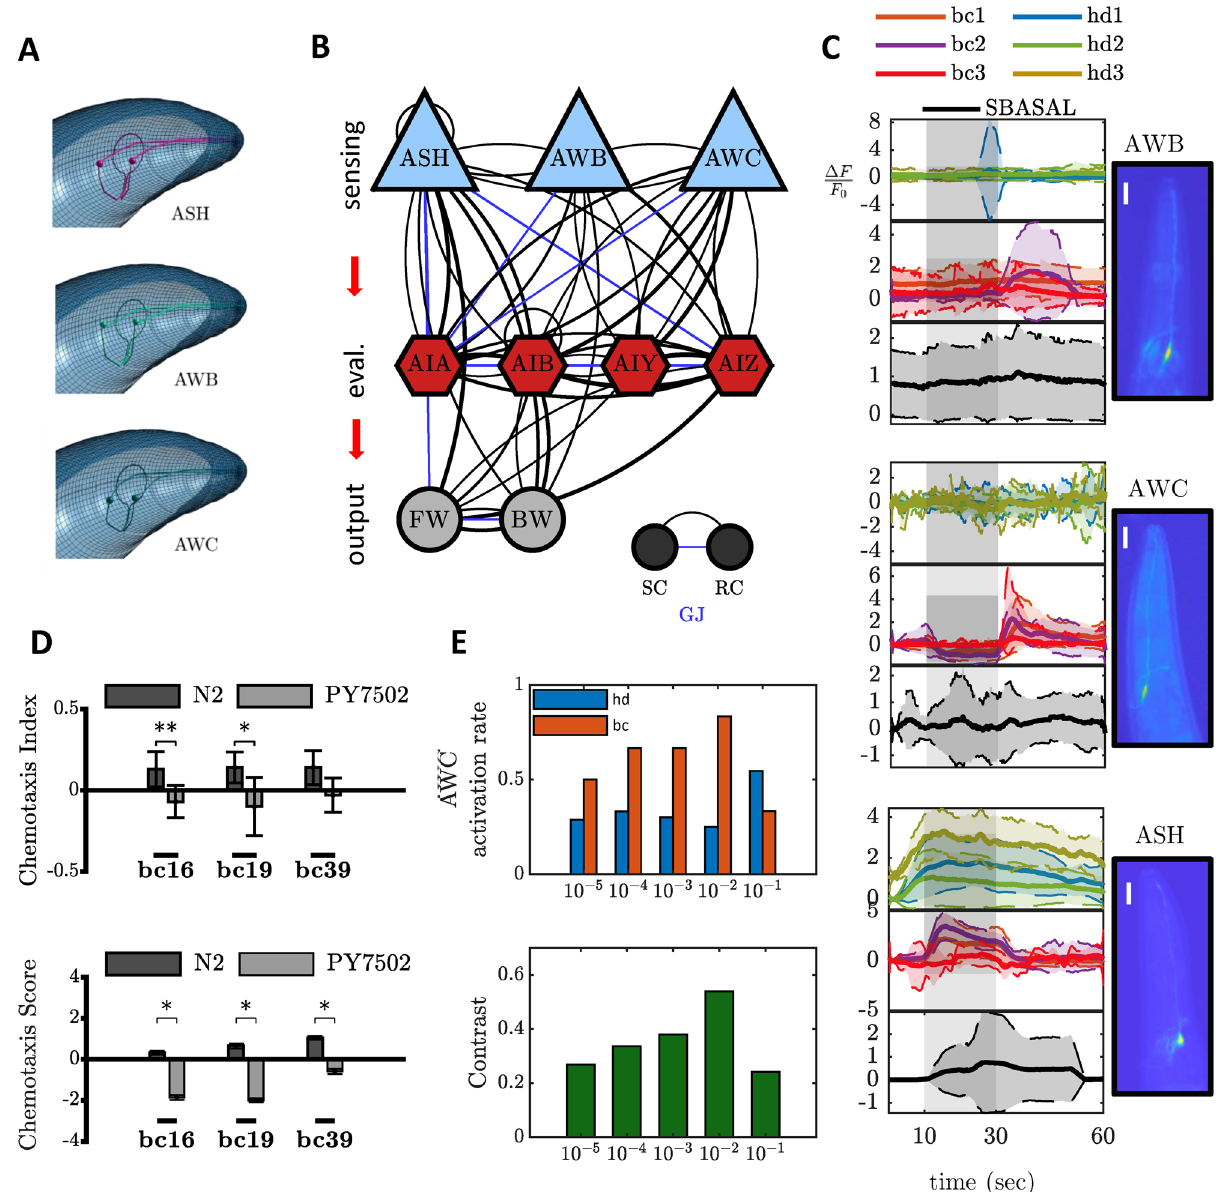
Figure 2. AWC is the main olfactory neuron mediating attraction towards cancer urine samples. ( A ) Head chemosensory neurons mediating aversive response (ASH and AWB) and attraction (AWC), with processes extending to the tip of the nose. ( B ) Olfactory sensory neurons, downstream interneurons, and motoneurons. ( C ) Mean calcium imaging traces normalized according to the standard deviation (N=6) from (top to bottom) ASH, AWB, and AWC neurons responding to control samples (repulsive), cancer urine samples (attractive), and to SBasal (neutral). Stimulation time is shaded in grey. AWC ON neurons show the most reliable responses, making them the best candidate for comparisons with the CI. We show the results from the samples that we first collected and that were readily available. ( D ) AWC neurons sense cancer metabolites. Population (top) and single-animal (bottom) chemotaxis assays showed that AWC genetically ablated worms are unable to sense cancer metabolites. Bar plots indicate chemotaxis indices or chemotaxis scores in response to three informative cancer samples (bc16, bc19, and bc39). Error bars reported in population assays indicate SEM of three independent experiments carried out on the same day on different plates (*p <0.05; **p <0.002, Student’s t-test). Error bars of single-animal chemotaxis assays indicate SEM of several tested animals (bc16: N2= 25, PY7502= 28; bc19: N2= 28, PY7502= 29; bc39: N2= 31, PY7502= 27) (*p <0.05, Mann-Withney test). ( E ) The top graph reports the activation rate (y-axis) of AWC ON neurons in response to removal of urine samples of cancer subjects (bc) or control samples (hd) for solutions with rising concentrations (from 10 −5 to 10 −2 ). The bottom graph shows the resulting contrast for each concentration. The concentration of 10 −2 yields the highest activation rate (83.33%) and a reasonably good contrast between control and positive